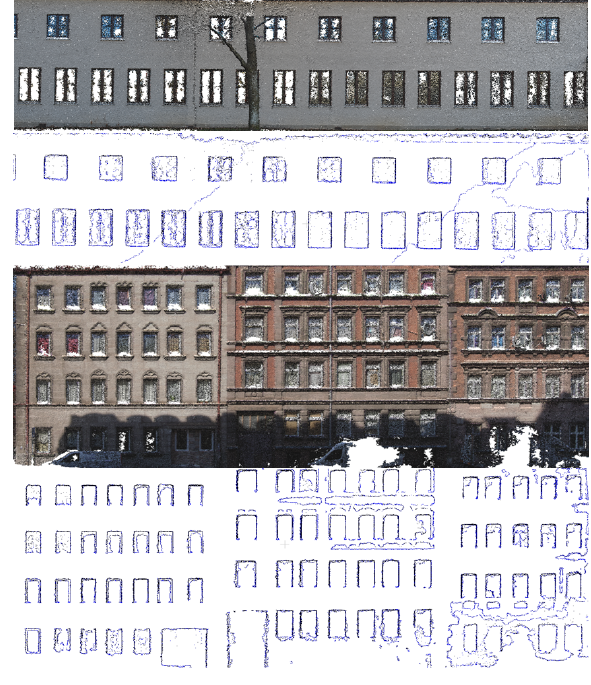
Figure 3: The point clouds of two facades are shown above a single hypothesis boundary estimates. The boundary